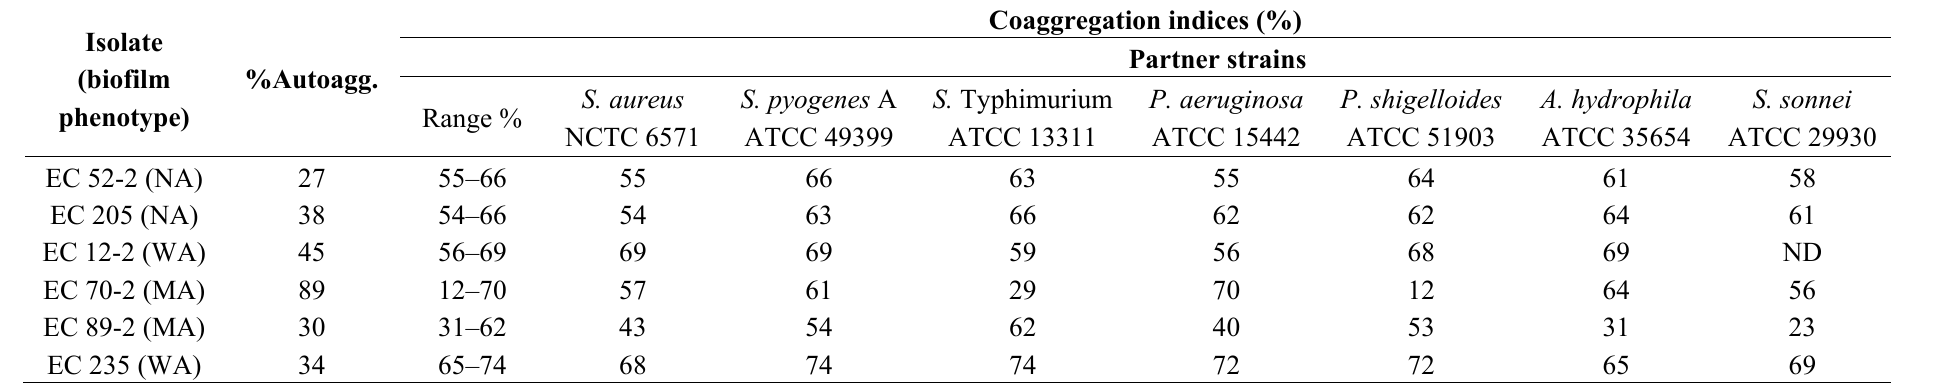
Table 3. Coaggregation indices of selected biofilm forming E. cloacae strains with seven different reference strains